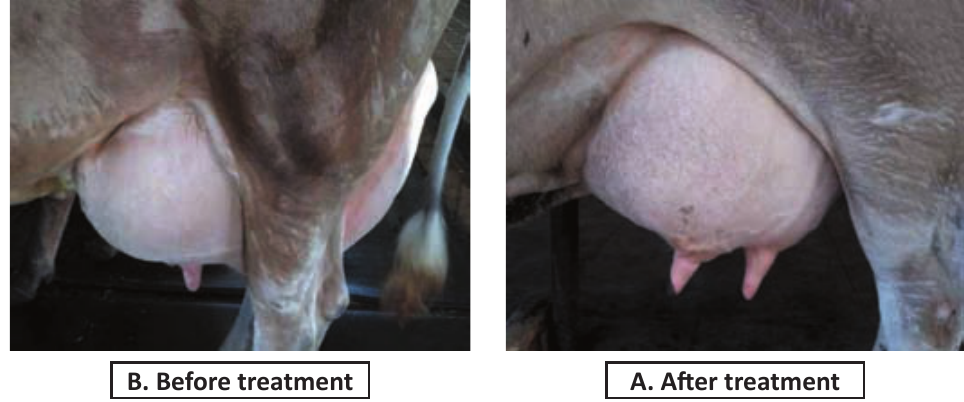
Fig 1. Changes in clinical manifestation of animals before and after